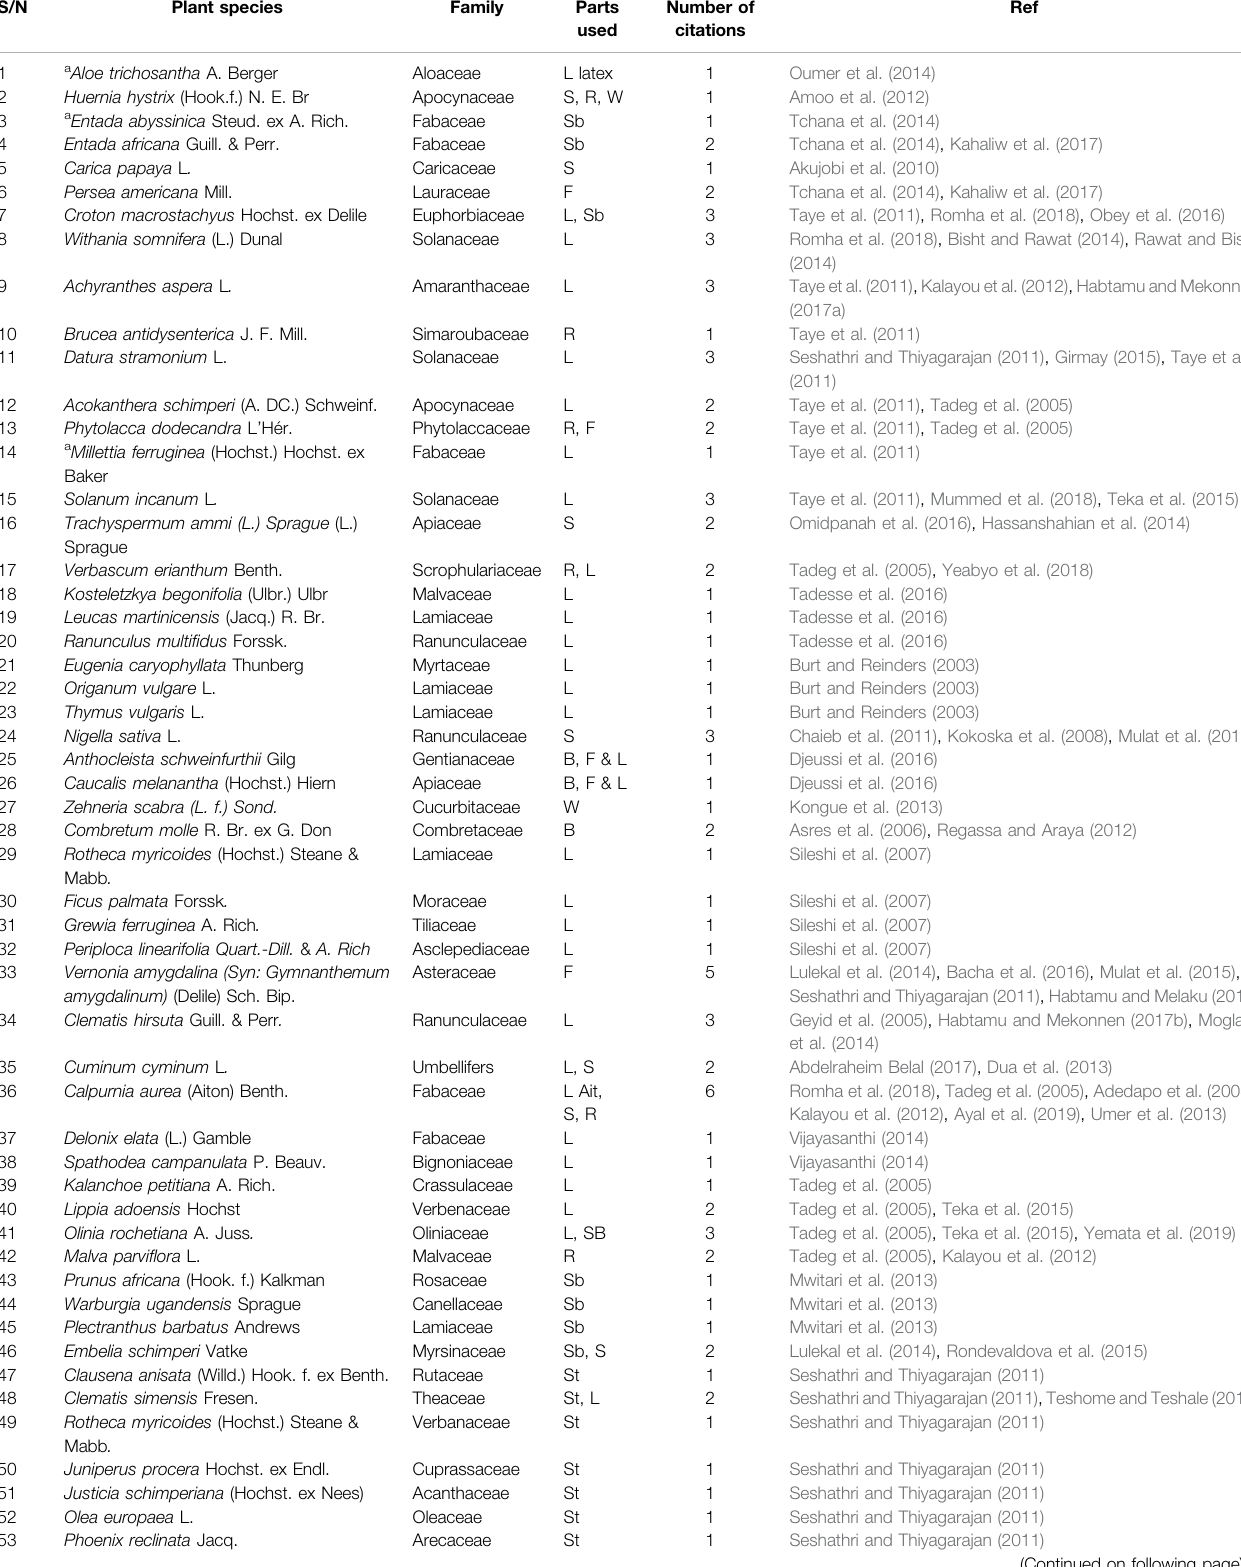
TABLE 1 | Summary of common medicinal plants identi fi ed from literature search as